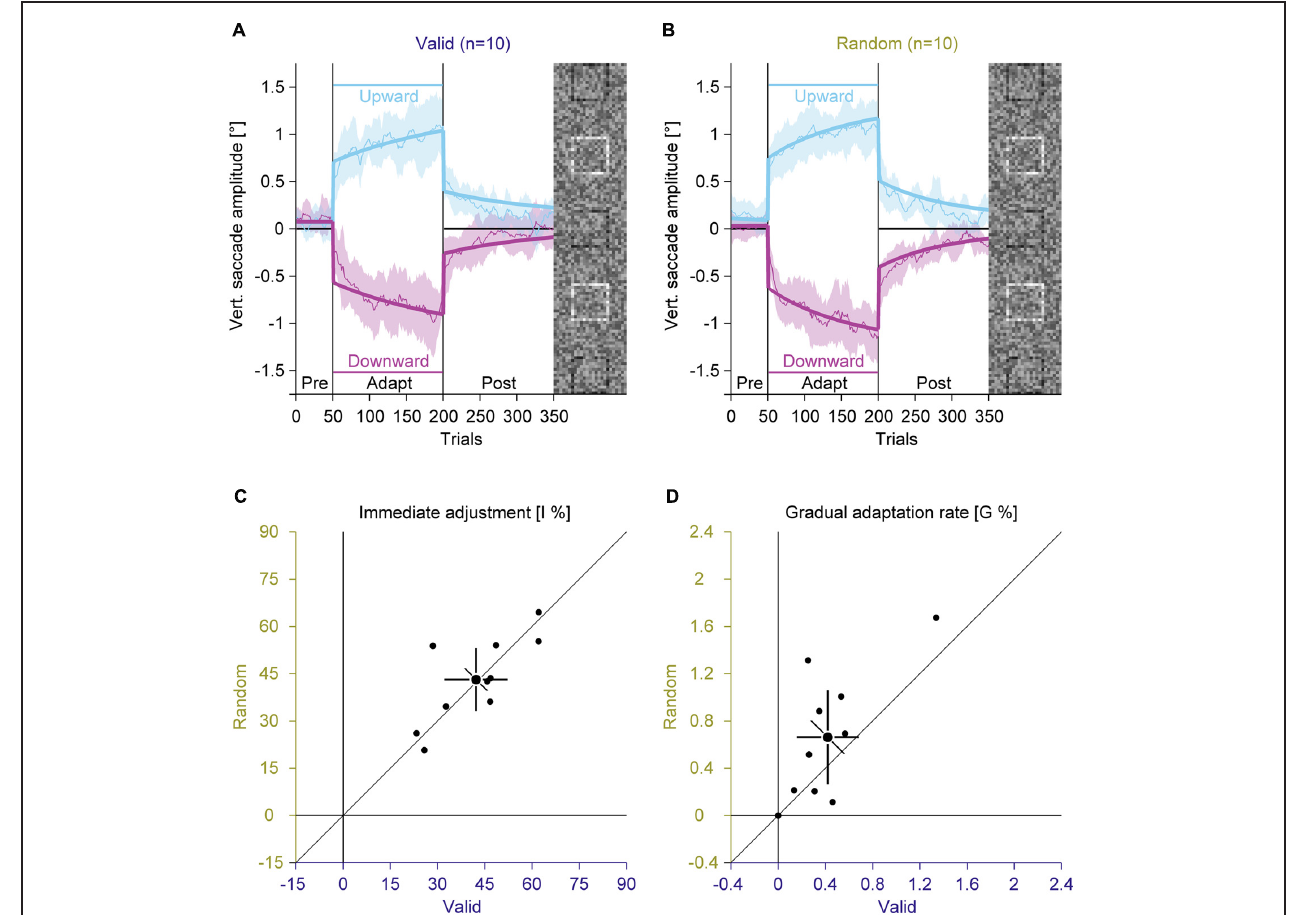
FIGURE 4 | Experiment 2, saccadic adaptation with valid and random feedback about the perceptual judgement. (A) Saccadic adaptation with valid feedback about the perceptual judgement. (B) Saccadic adaptation with random error feedback about the perceptual judgement. (C) Immediate adjustment in the two-state model fits. (D) Gradual adaptation rate in the two-state model fits. (A–D) Conventions are the same as in Figure 3